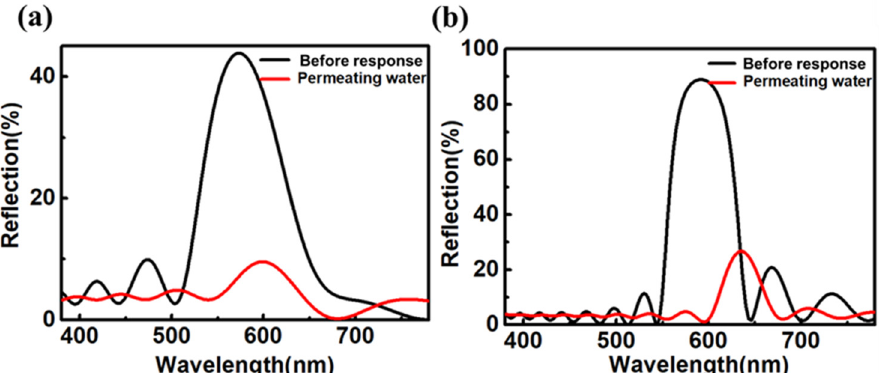
Figure 10. Simulation results of reflection spectra of IO structure composed of PGEDA matrix and void arrays with ( a ) 6 layers and ( b ) 12 layers before and after response to water.